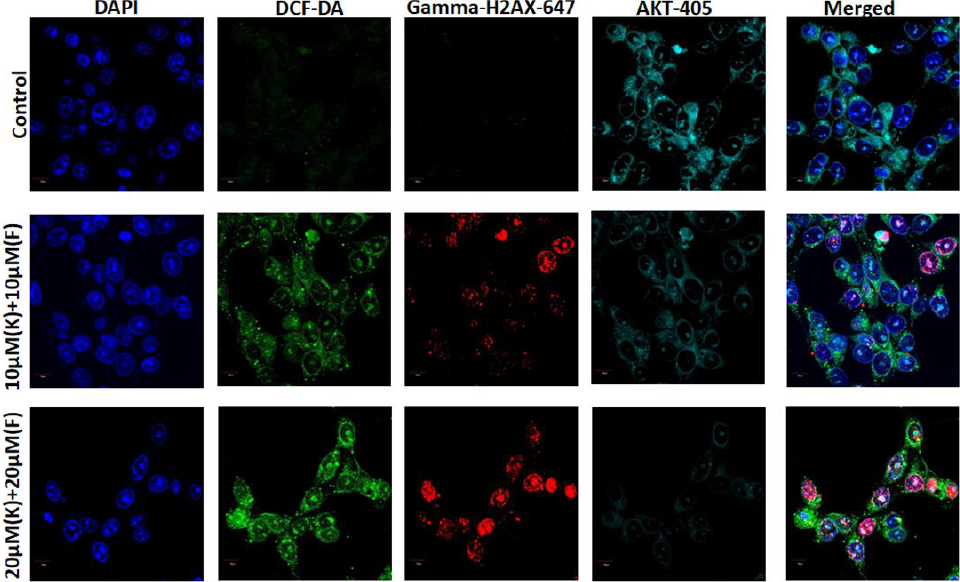
Figure 5. ROS, γ-H2AX, and Akt expressed after treatment with 10 and 20 μM (K + F) against MDA- Figure 5. ROS, γ -H2AX, and Akt expressed after treatment with 10 and 20 µ M (K + F) against MB-231 cells after 24 h by confocal microscopy; DAPI was used as a nuclear stain. MDA-MB-231 cells after 24 h by confocal microscopy; DAPI was used as a nuclear